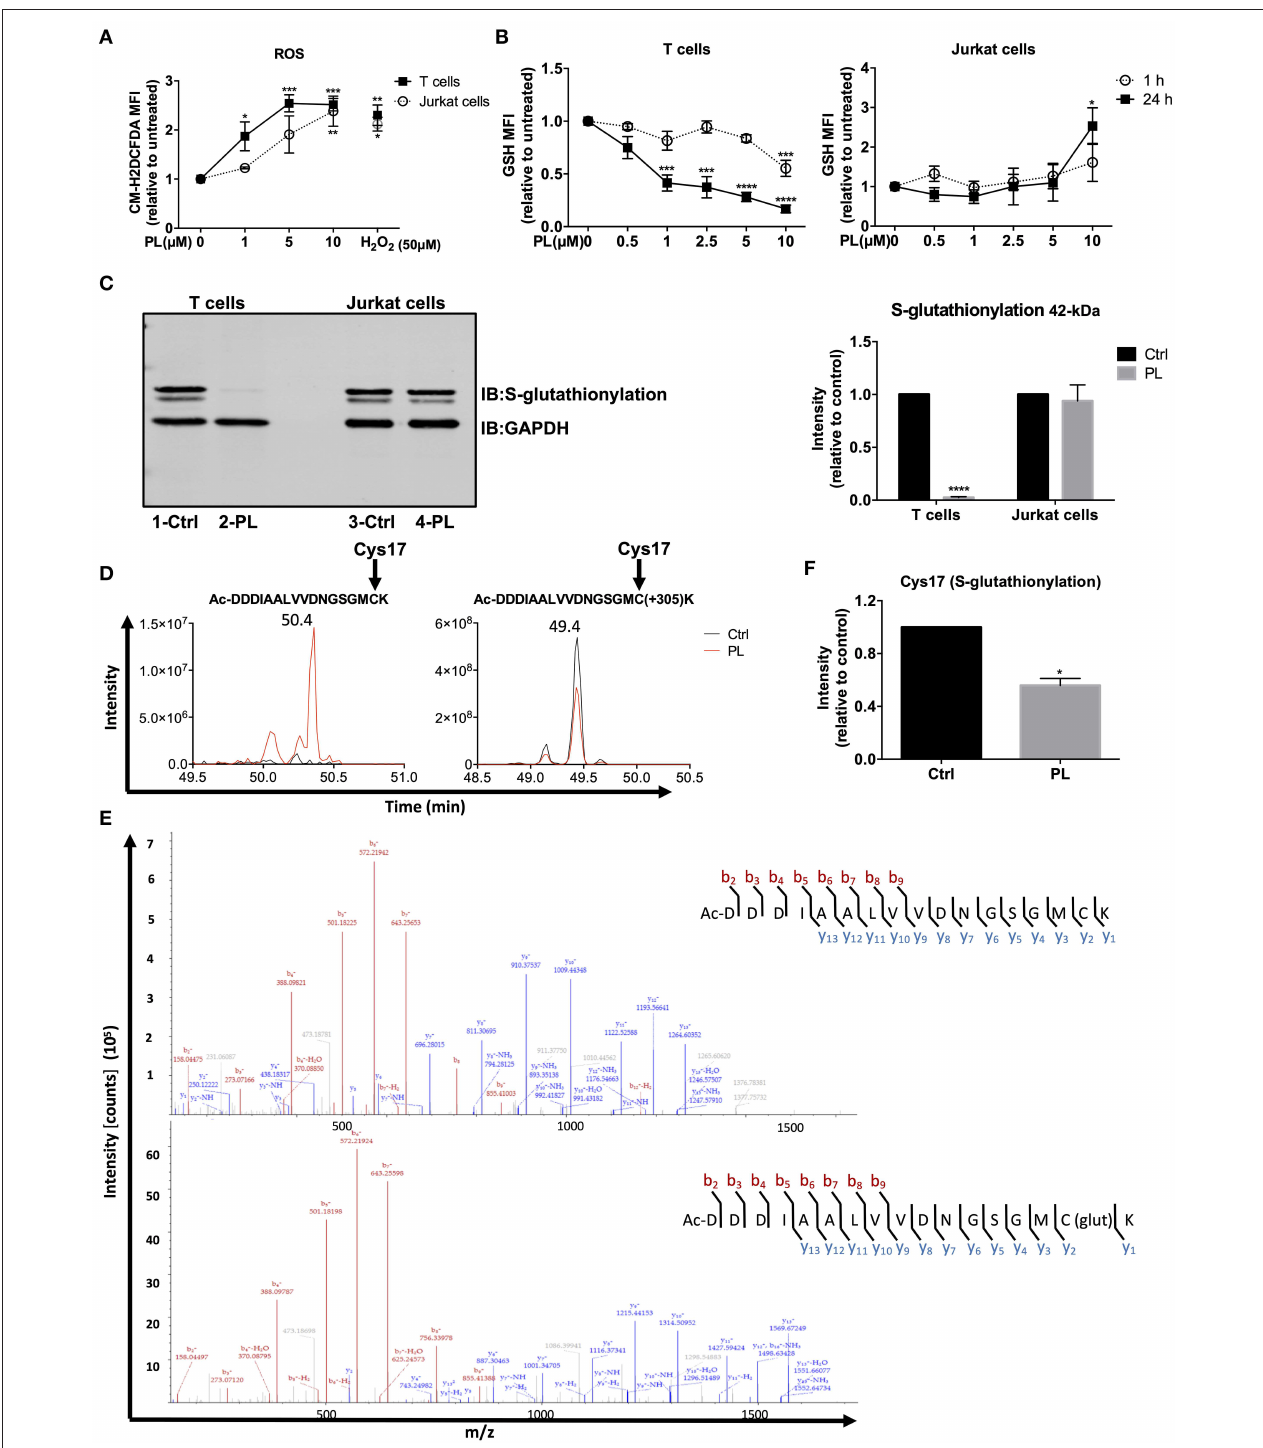
FIGURE 1 | PL induces a prooxidative state in primary human T cells. (A) The intracellular ROS levels were assessed by flow cytometry. Primary human T cells (black squares) and Jurkat cells (open circles) were preloaded with CM-H 2 DCFDA and, thereafter, treated for 1h with or without PL as indicated ( n = 3; mean; SEM; * p < 0.05, ** p < 0.01, *** p < 0.001). (B) Intracellular GSH levels of T cells (left panel) and Jurkat cells (right panel) were assessed by flow cytometry. Cells were treated with or without PL as indicated for 1h (open circle) or 24h (black square) and stained with ThiolTracker TM violet dye for 15min ( n = 3; mean; SEM; * p < 0.05, *** p < 0.001, **** p < 0.0001). (C) Protein S-glutathionylation was detected by western blotting. Representative immunoblot (left) shows the S-glutathionylated 42-kDa